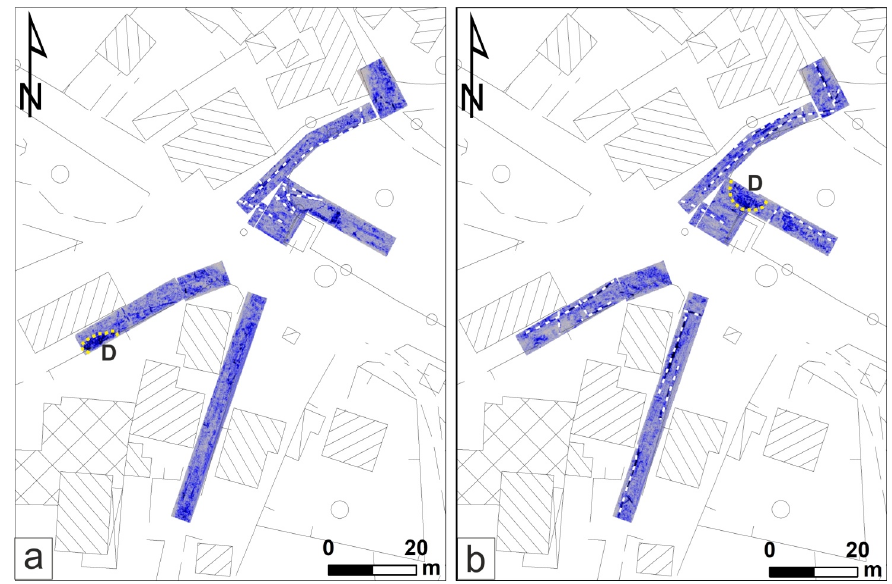
Figure 15. Exemplary 3D GPR depth slices at 0.50 ( a ) and 0.85 m ( b ). Yellow dashed lines mark main depocenters (D), while white lines mark some of the imaged pipes.